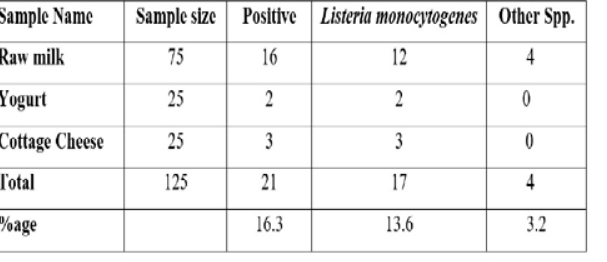
Fig. 4 Labelling of agar plates 3.3. Streaking After the labelling, streaking was